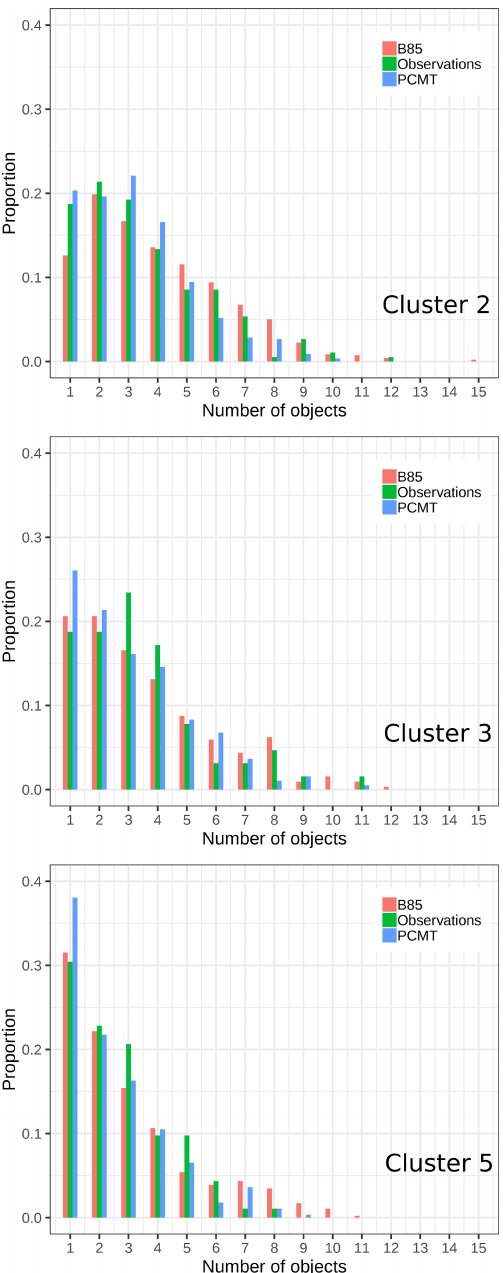
Figure 11. Normalized histograms of the daily number of SAL pat- terns, for the B85 physics scheme (red), PCMT (blue), and obser- vation (green). Panels correspond to the three-cluster classification.